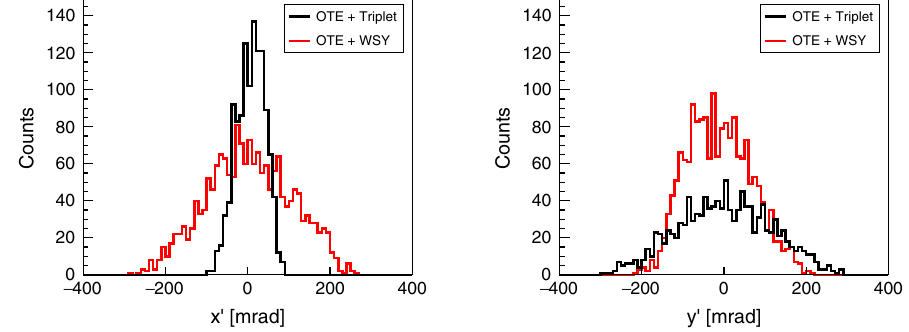
FIG. 9. Comparisons of the transverse divergences for different beam spots. Left: horizontal direction; right: vertical direction.